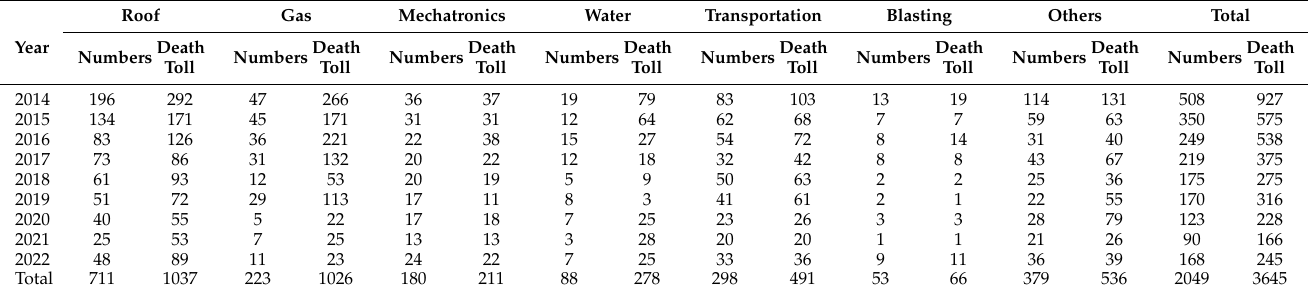
Table 1. Incomplete statistics of all kinds of death accidents in coal mines in China from 2014 to